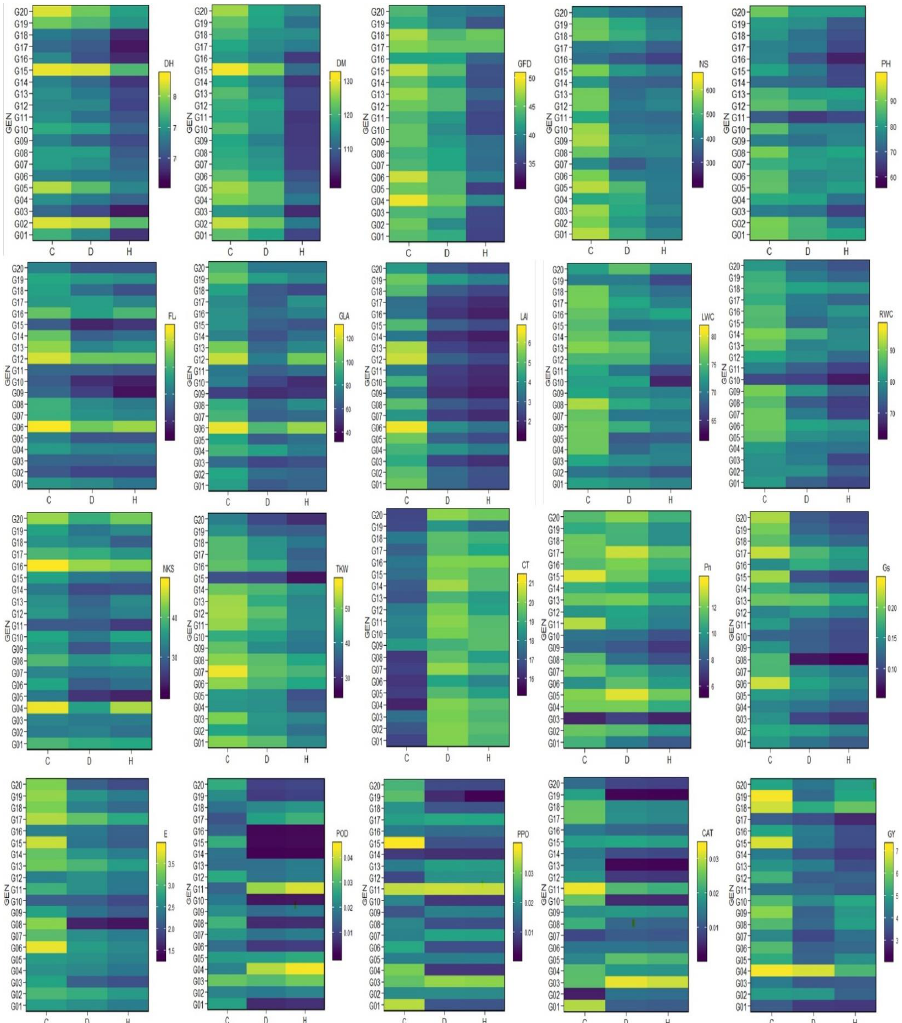
Figure 1. Plotting the mean performance of the 20 measured traits as the overall mean across three seasons of 20 wheat genotypes with the three treatment groups: control (C), drought stress (D), and heat stress (H).Abbreviations as described in materials and methods Table 2. Analysis of the variance of the seasons (S), genotypes (G), and their interactions (S × G) for the 20 studied traits of 20 wheat genotypes measured in three seasons.